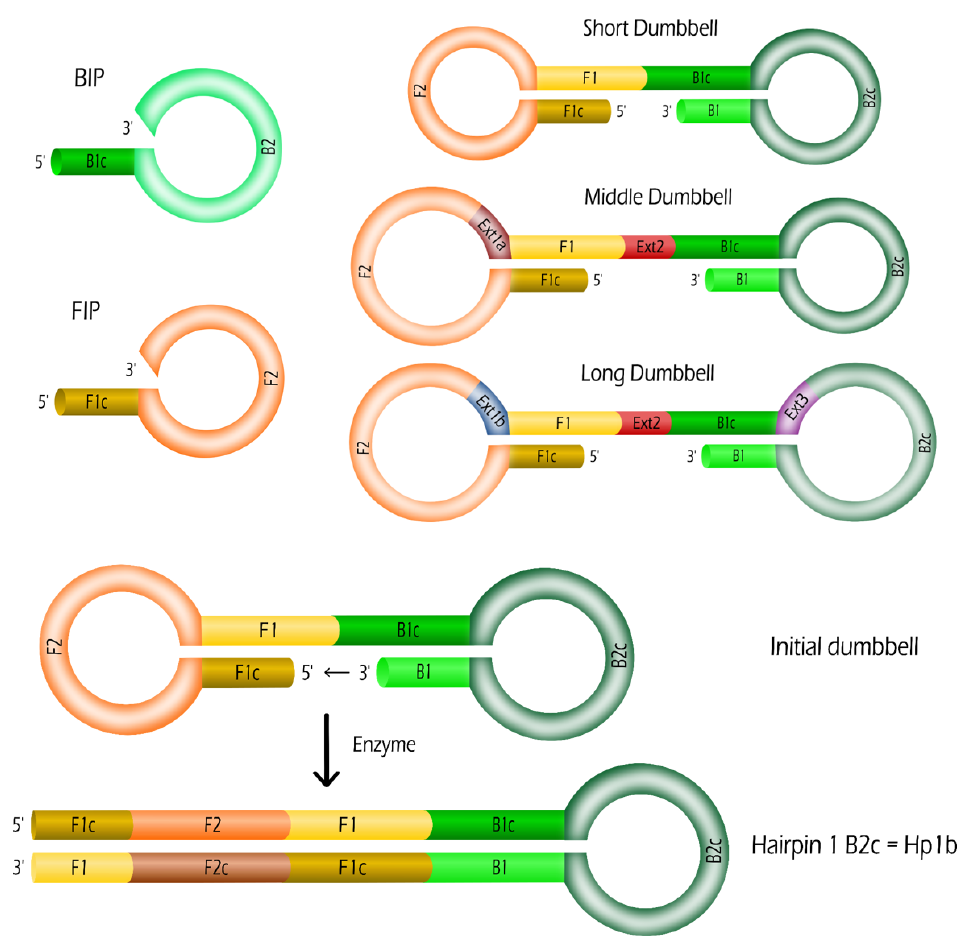
Figure 1. The primers (BIP and FIP) and the dumbbells (Short dumbbell SD, middle dumbbell MD and long dumbbell LD) are depicted with their name sequences and respective extensions. At the bottom, the formation of the hairpin Hp1b from SD is obtained from an enzymatic extension of the 3 (cid:48)